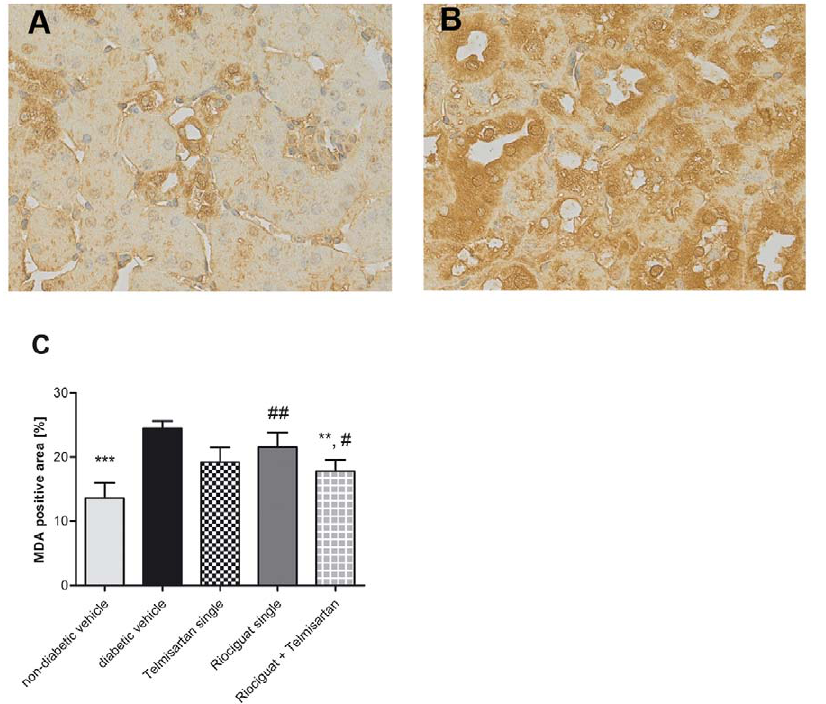
Figure 3. Significant reduction of MDA- positive renal tissue by combination therapy: Immunhistochemical detection of MDA in non-diabetic (A) and diabetic (B) untreated eNOS knockout mice. Percent volume of MDA-positive area in renal cortex (F). Values are given as means 6 SEM. For comparisons, student’s t test was used. ** p , 0.01; *** p , 0.001 vs. diabetic vehicle and # p , 0.05; ## p , 0.01 vs. non-diabetic vehicle. Abbreviations used: MDA ,